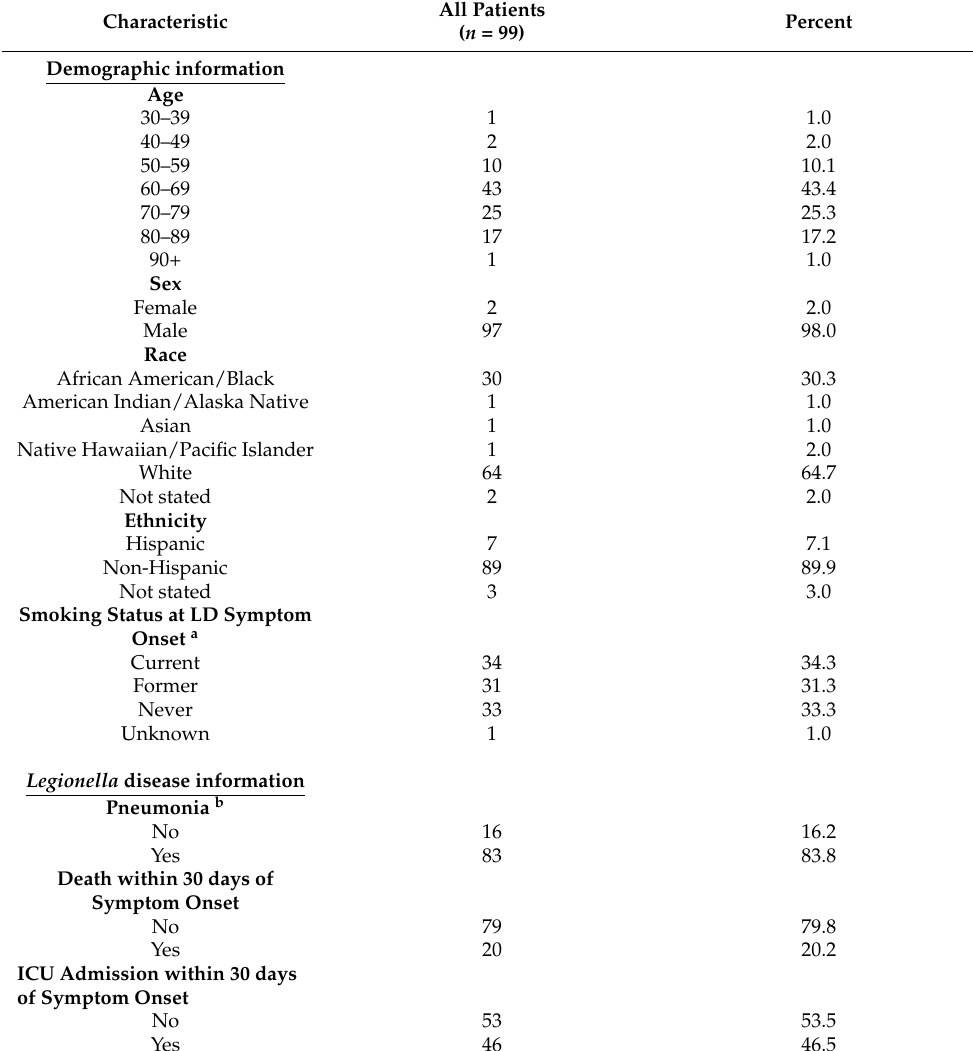
Table 2. Demographics, smoking status, and Legionella disease indicators of 99 HCA LD patients.